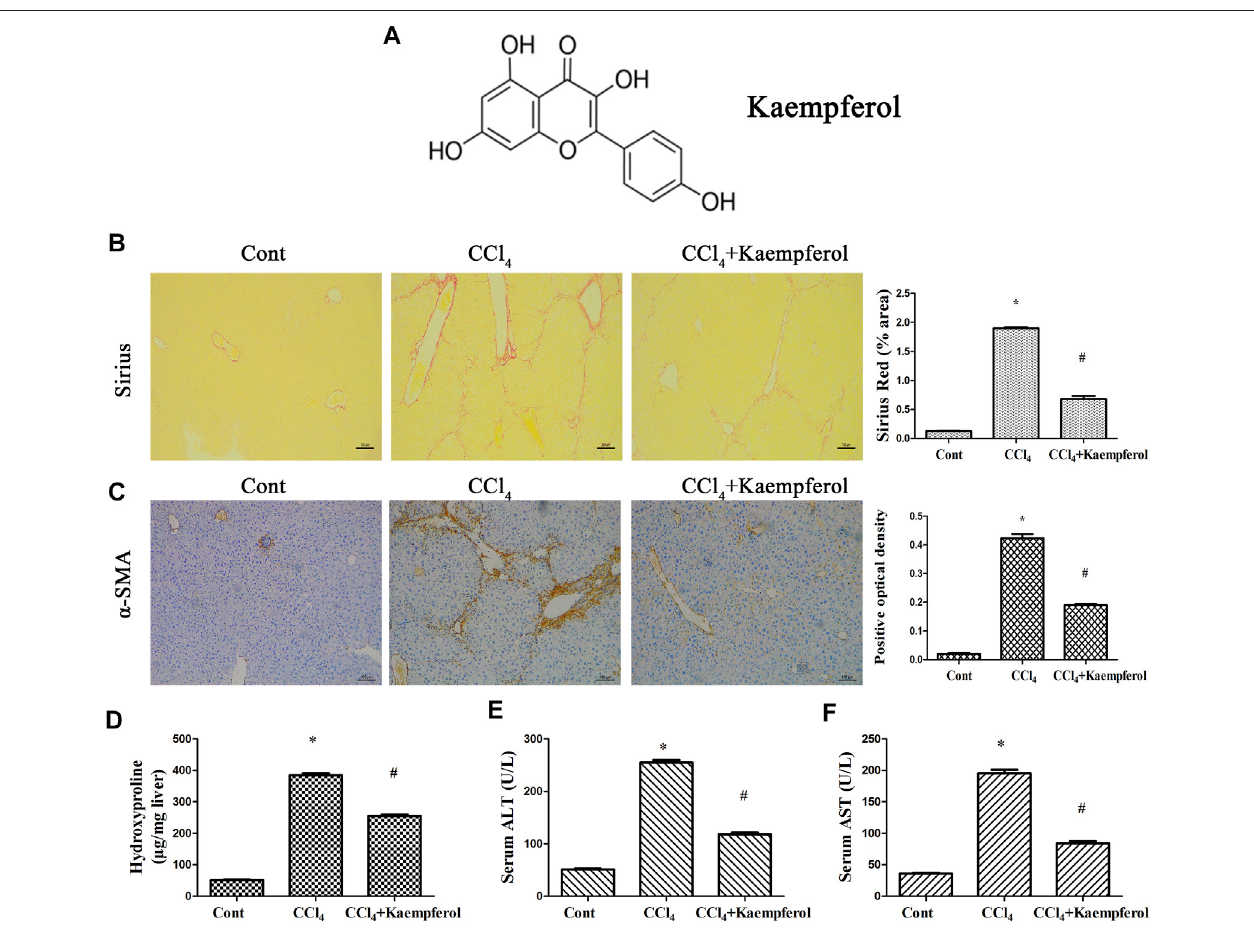
FIGURE 1 | Kaempferol alleviates liver fi brosis caused by CCl 4 in vivo . (A) The chemical structure of kaempferol. (B) Analysis of Sirius Red staining for collagen deposits. Scale bar, 100 μ m. (C) Analysis of α -SMA immunohistochemistry.Scale bar, 100 μ m. (D) Hydroxyproline level. (E) Serum ALT level. (F) Serum AST level. * p < 0.05 compared with the control and # p < 0.05 compared with CCl 4